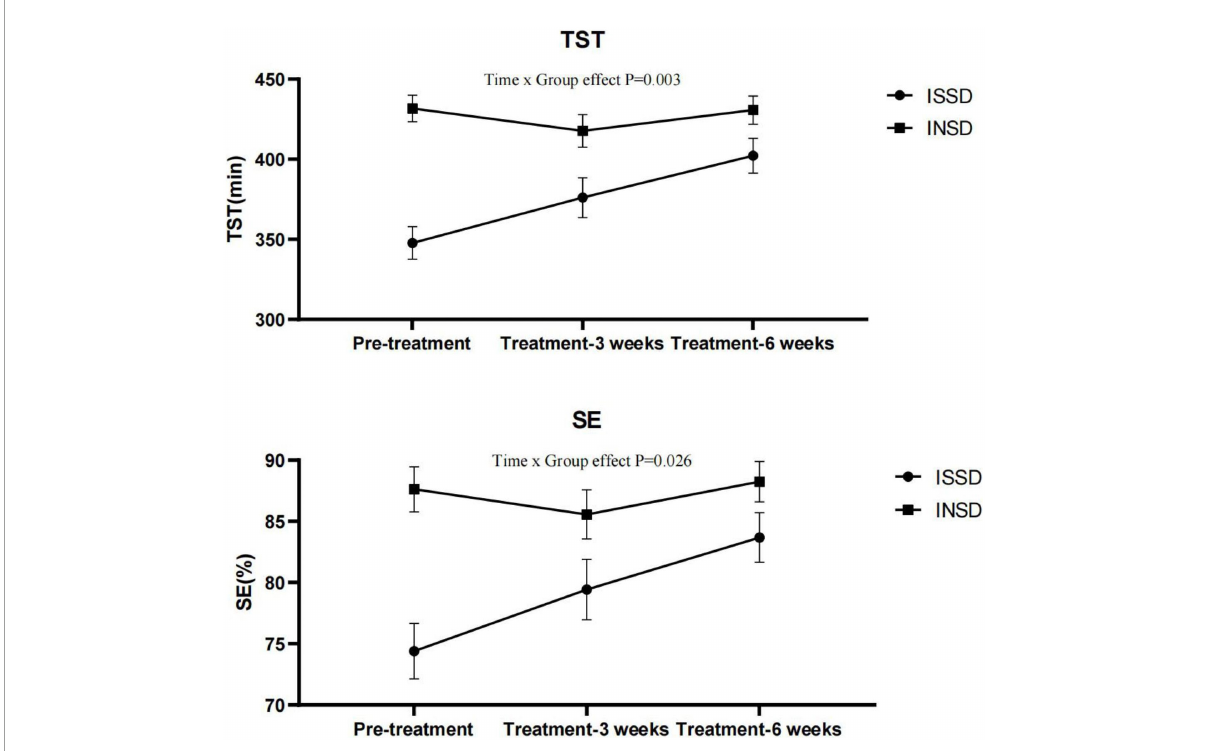
FIGURE2 Total sleep time and sleep efficiency before and after electrostatic therapy in the ISSD and INSD groups. INSD, insomnia with normal sleep duration; ISSD, insomnia with short sleep duration; TST, total sleep time; SE, sleep efficiency. All data were presented after control for age, gender and BMI. Error bars present standard error.